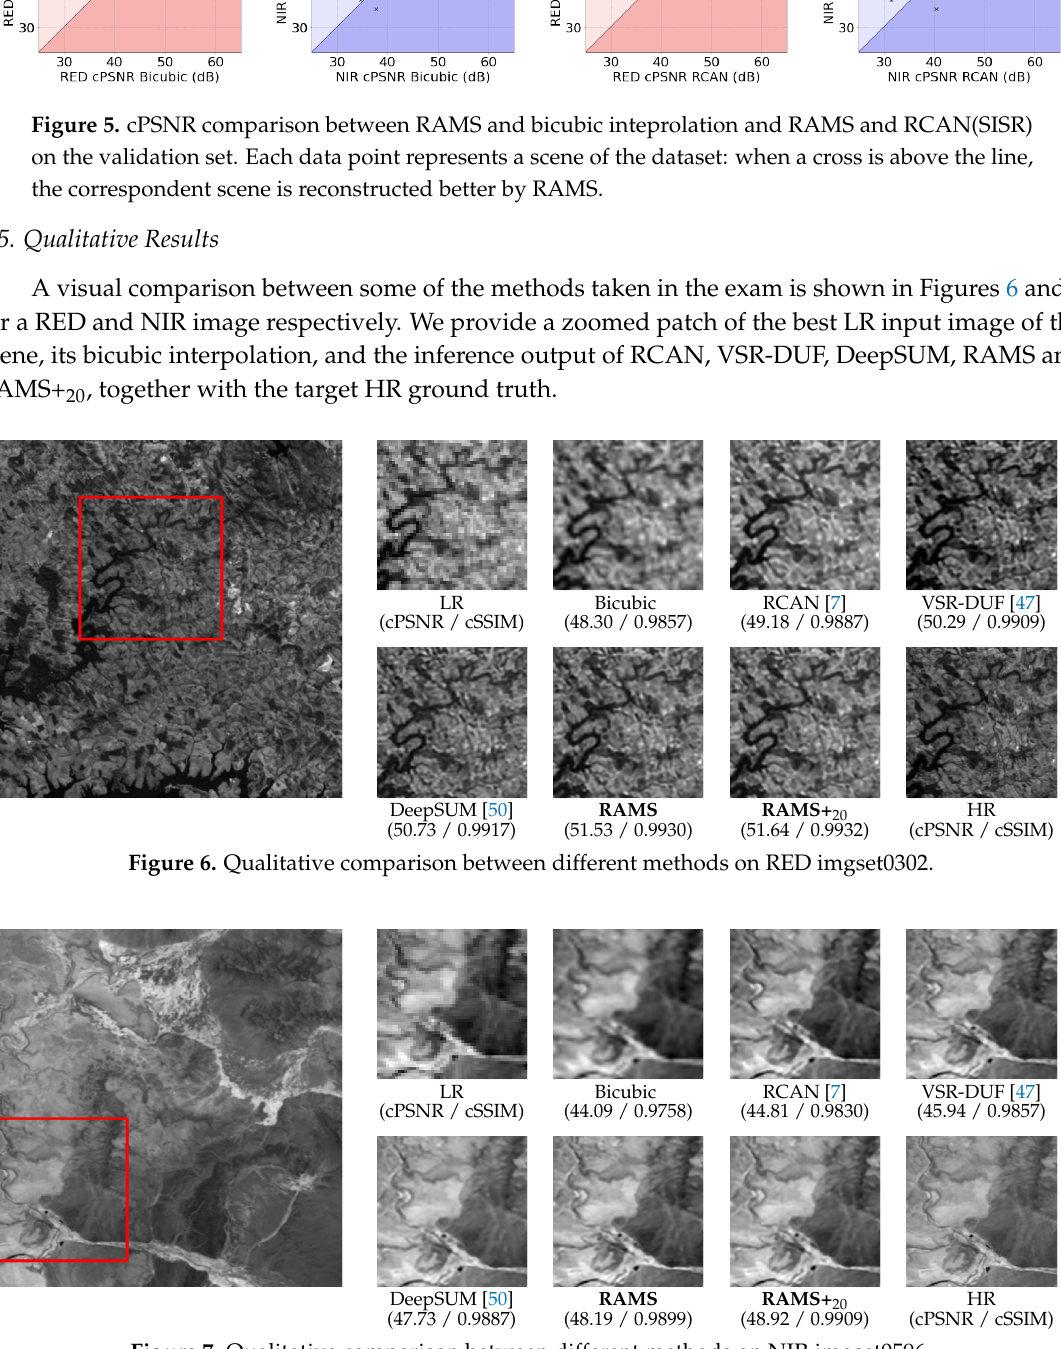
Figure 7. Qualitative comparison between different methods on NIR